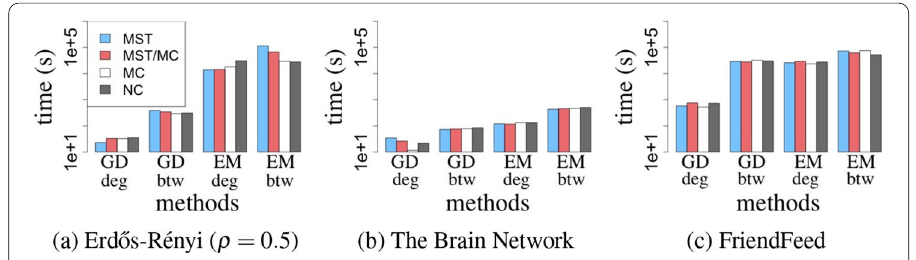
Fig. 7 Time elapsed to sparsify three networks using different sparsification methods. a and b has been sparsified with α = 0.45 and FriendFeed, α =